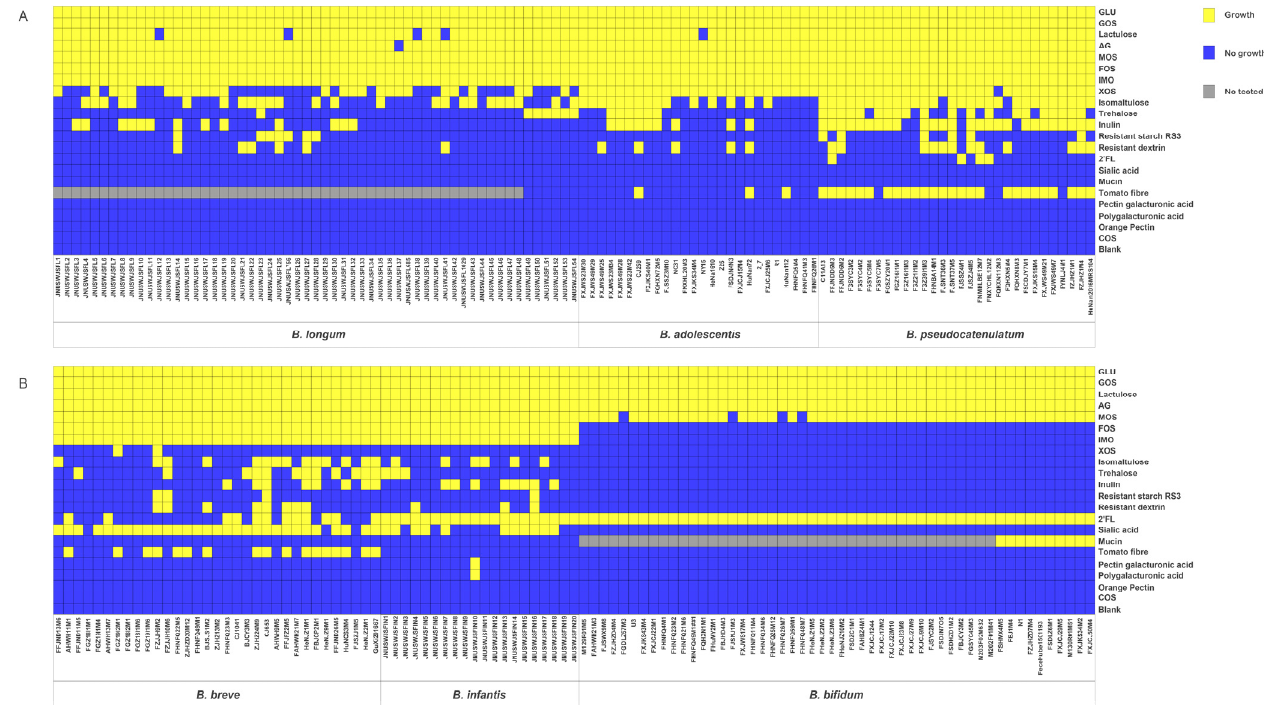
Figure 1. Evaluation of carbohydrate utilization. ( A ), Heatmap illustrating the growth performance of adult-type bifidobacterial strains on different carbon sources. ( B ), Heatmap showing the growth performance of infant-type bifidobacterial strains on different carbon sources.